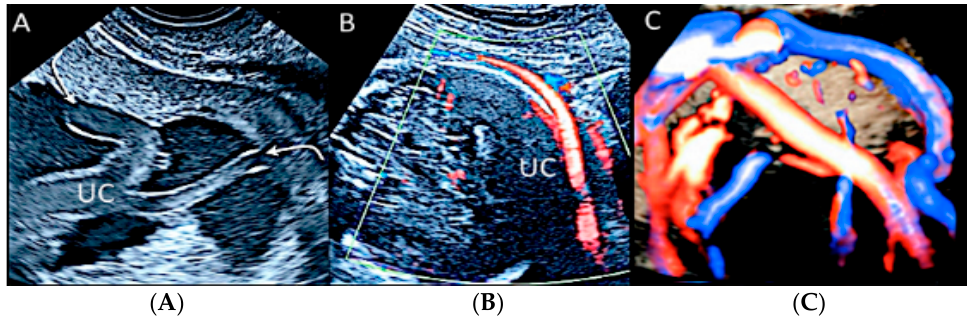
Figure 22. Pregnancy at 20 weeks gestation. Two-dimensional ultrasound ( A ), color Doppler ( B ) and four-dimensional STIC with color Doppler ultrasound ( C ). In velamentous insertion, the umbilical cord vessels (UC) diverge from each other, inserting into the membranes not supported by Wharton jelly, before entering the placental tissue (curved arrows, figure on the left) ( A ). The diagnosis of velamentous cord insertion is made through color Doppler ultrasound by the discovery of splayed umbilical vessels at the periphery of the placenta ( B ). It may be associated with vasa praevia (Type I) when umbilical vessels running through the fetal membranes are close to the internal cervical os (figure on the center). Four-dimensional STIC with color Doppler ultrasound ( C ) image showing the “mangrove sign” for velamentous cord insertion.